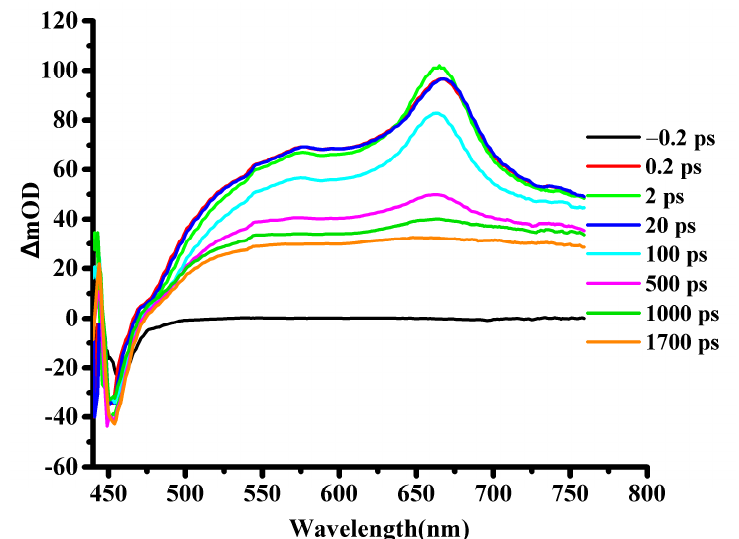
Figure 4. Femtosecond transient absorption spectrum.